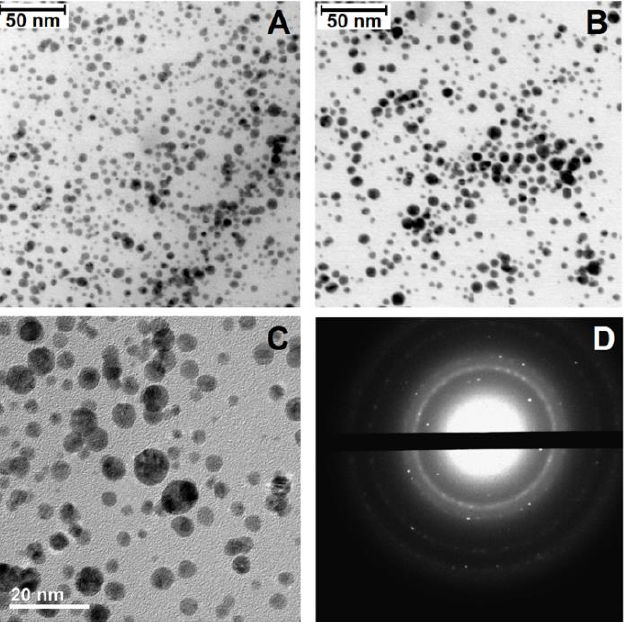
Figure 4. The BF TEM image of the VT – Au(III) solutions (40/1) irradiated at initial pH 5.5 up to a dose of 14 ( A ) and 23 kGy ( B ); the HRTEM image ( C ) together with SAEDP ( D ) of the VT – Au(III) solutions (40/1) irradiated up to a dose of 23 kGy.